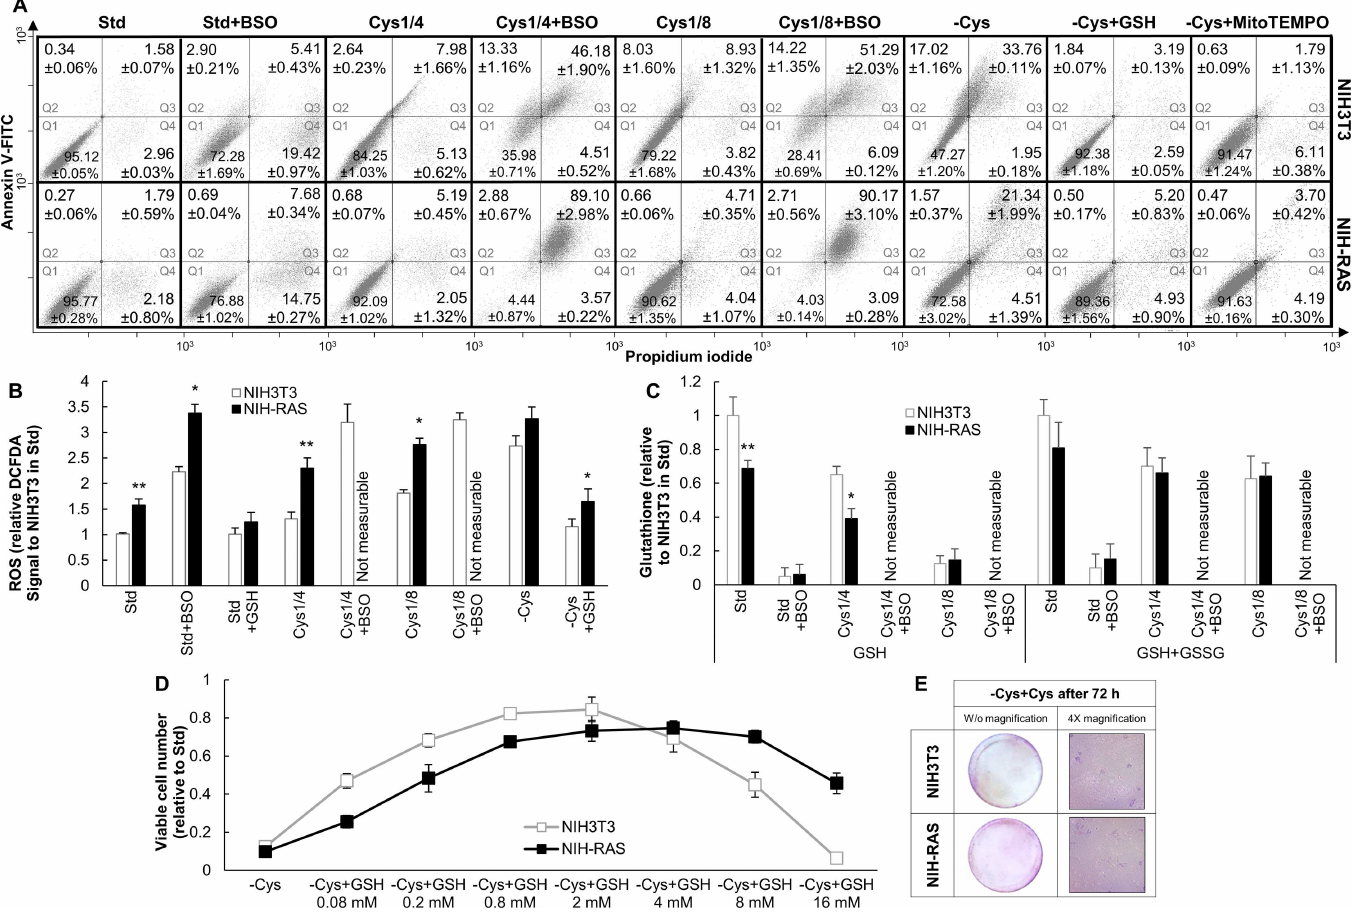
Fig 2. Viability and redox state under cysteine deprivation and limitation. (A) Representative dot plots for NIH3T3 and NIH-RAS cells stained with Annexin V-FITC and propidiumiodide and analyzedby FACS after 30 h of growth under conditionsindicated.Q1 = quadrant1, healthy cell; Q2 = quadrant2, early apoptotic cells; Q3 = quadrant 3, late apoptotic cells; Q4 = quadrant 4, necrotic cells. MitoTEMPO and buthionine sulfoximine(BSO) were used at the concentration of 10 μ M and 100 μ M, respectively. The values reported for each quadrant are the mean +/- standard deviationof three independent experiments. (B) Relative ROS levels in NIH3T3 and NIH-RAS cells grown for 48 h under conditions indicatedas determined by DCFDA (2’,7’- dichlorodihydrofluorescein diacetate)staining. Each bar represents the mean of at least three independent experiments with error bars representing the standard deviation.(C) Reducedand total glutathionelevels (measured as describedin [55]) in NIH3T3 and NIH-RAS cells grown for 48 h under conditions indicated.Each bar represents the mean of at least three independent experiments with error bars representing the standard deviation. (D) Cell proliferation of NIH3T3 and NIH-RAS cells grown for 48 h in cysteine-free medium supplemented with different concentrations of glutathione. Plotted data are mean +/- standard deviationcomputedfrom at least three independent experiments. * P < 0.05; ** P < 0.01 (Student’s t -test). (E) Crystal violet staining of NIH3T3 and NIH-RAS cells plated at the density of 9000 cells/cm 2 , grown for 72 h under cysteine deprivation and then for 48 h in standard